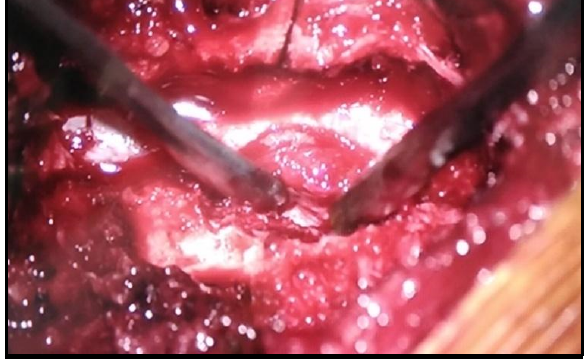
Figure 3. Intraoperative image of disc adhered to the dura.